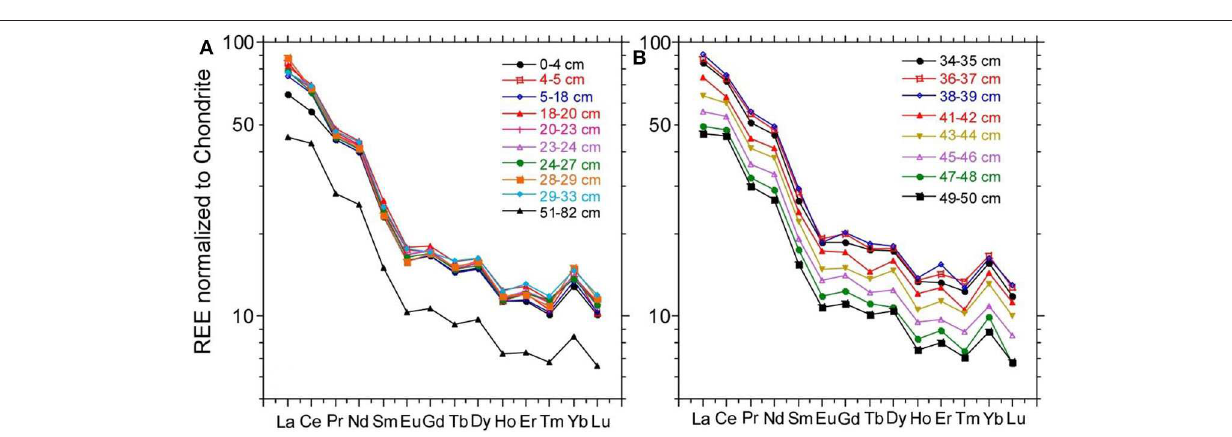
Frontiers in Earth Science |